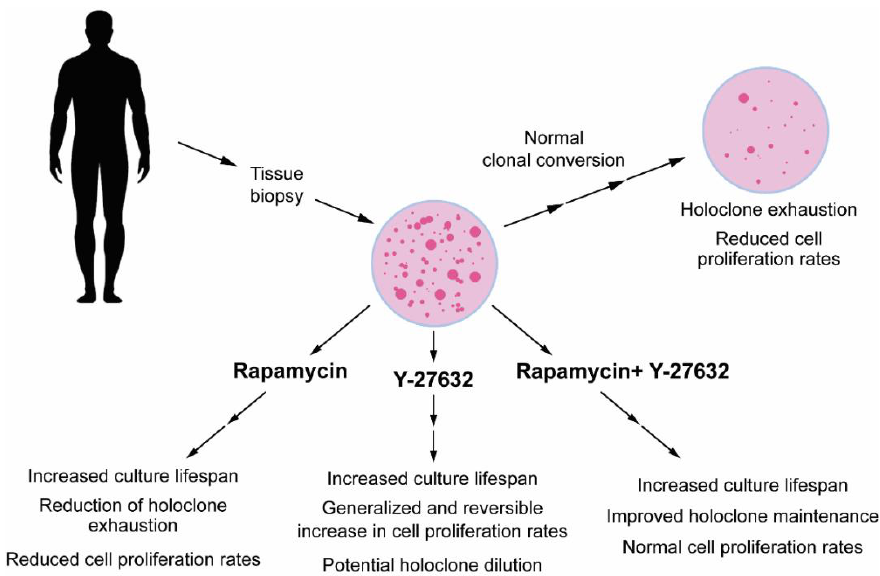
Figure 3. Summary of potential applications of rapamycin and Y-27632 in keratinocyte (stem cells) expansion for transplantation purposes. The diagram illustrates the normal process of clonal conversion and holoclone exhaustion occurring upon ex vivo expansion of keratinocytes isolated from patients’ stratified epithelia via a tissue biopsy. In the lower part of the figure are indicated advantages and disadvantages of the individual use of rapamycin and Y-27632 (see text and Table 1 for details) and the potential synergy of their combination for improving holoclone maintenance and expansion.